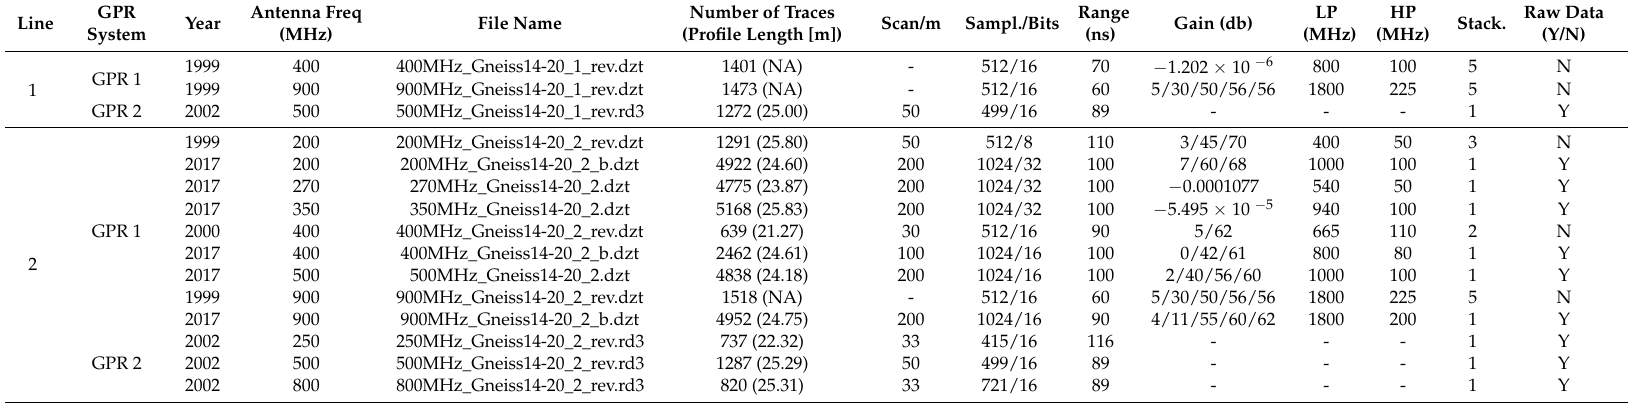
Table 6. Information about data collected in the Gneiss 14/20 gravel region. NA means not